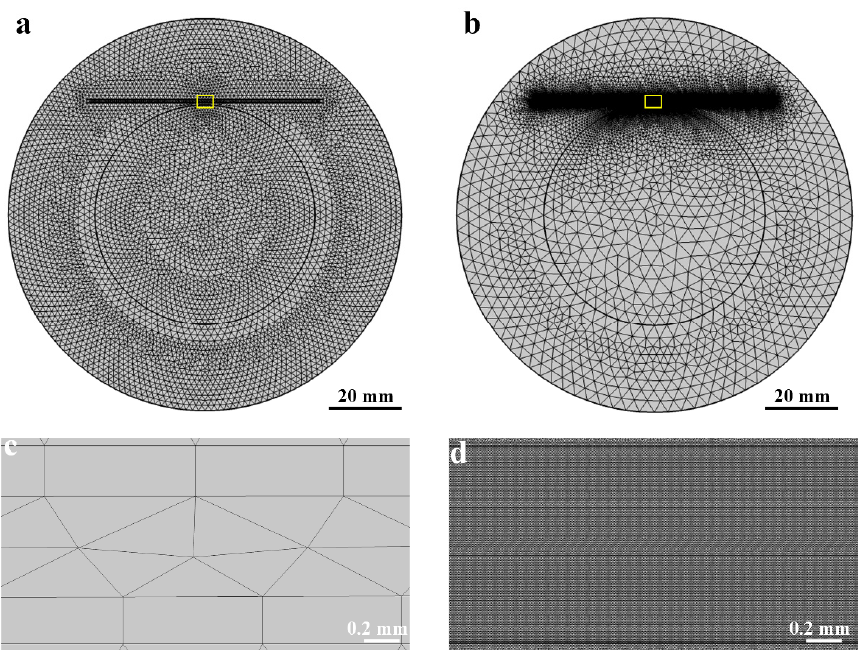
Figure 2. ( a ) Extremely fine mesh, ( b ) Local refinement mesh, and their corresponding enlarged ( c , d ) images of the mesh in the cavity (the yellow box), respectively.